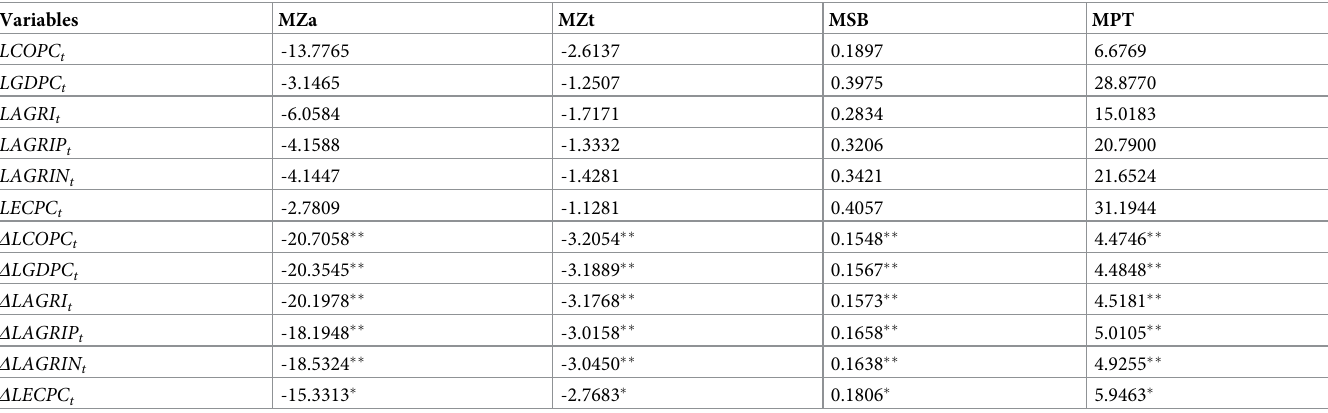
Table 2. Unit root test’s